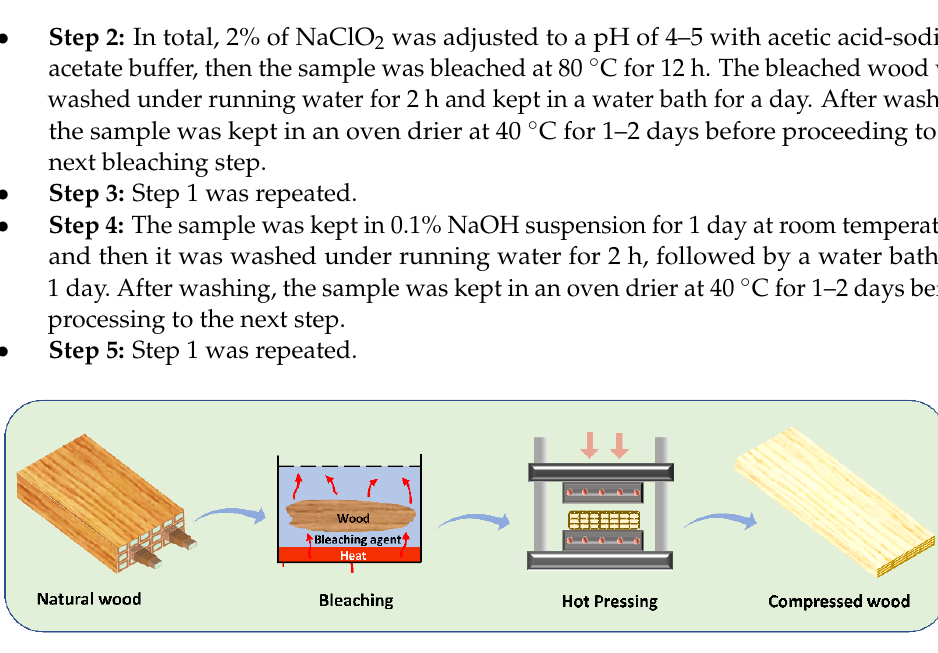
Figure 1. Compressed wood preparation process.